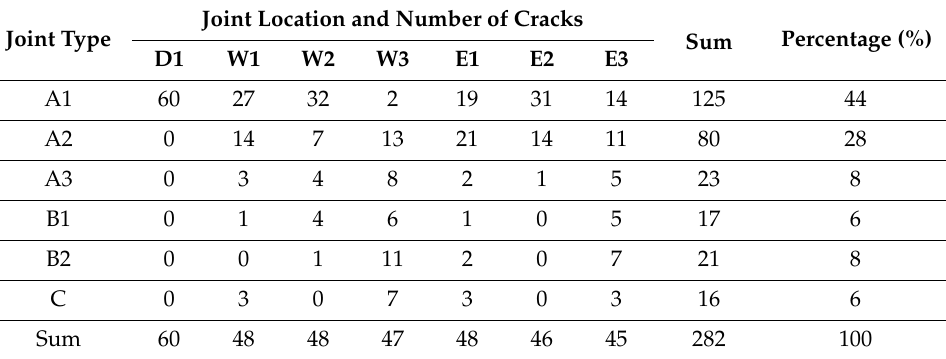
Table 2. The statistics of crack in concrete lining in di ff erent